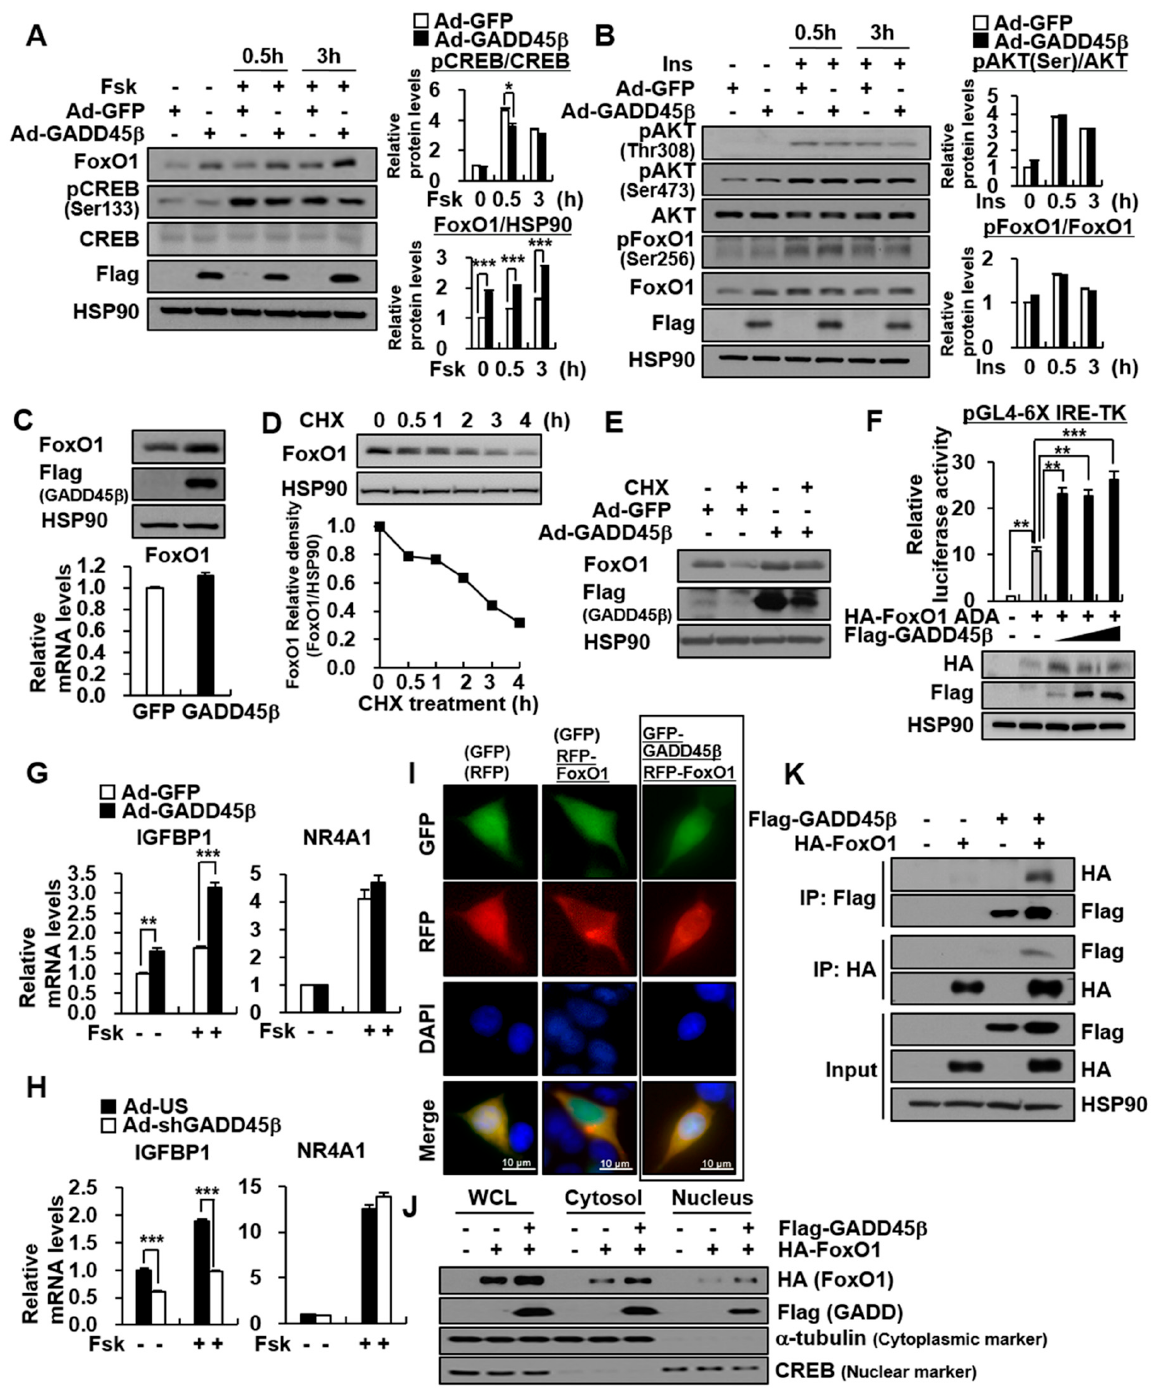
Figure 3. GADD45 β induces hepatic gluconeogenesis by enhancing FoxO1 protein stability rather than Akt-mediated FoxO1 phosphorylation and Fsk-induced CREB phosphorylation. ( A – C ) Mouse primary hepatocytes were infected with Ad-GFP or Ad-GADD45 β for 48 h. ( A ) Cells were treated with 10 uM Fsk for 0.5 or 3 h. Western blot showing the effects of GADD45 β on FoxO1 protein level and CREB phosphorylation level ( left ). Bar graph showing the ratio of pCREB to CREB and FoxO1 toHSP90 ( right ). ( B ) Cell were treated with 100 nM insulin for 0.5 or 3 h. Western blot showing the effects of GADD45 β on AKT phosphorylation level and FoxO1 phosphorylation level ( left ). Bar graph showing the ratio of pAKT (Ser473) to AKT and pFoxO1 to FoxO1 quantified by ImageJ ( right ). ( C ) Western blot ( upper ) and qPCR analysis ( bottom ) showing the effects of GADD45 β on FoxO1 protein and mRNA level. ( D ) Cycloheximide (CHX) chase assay showing the degradation rates of the existing FoxO1 protein. Mouse primary hepatocytes were treated with 25 ug/mL Cycloheximide (CHX) for 0.5, 1, 2, 3, or 4 h. Western blot ( upper ) and its quantification graph ( bottom ) showing FoxO1 protein levels. ( E ) Western blot and CHX chase assay showing the effects of GADD45 β on FoxO1 protein stability. Mouse primary hepato- cytes infected with Ad-GFP or Ad-GADD45 β were treated with or without 25 ug/mL CHX for 2 h. ( F ) Luciferase assay showing effects of GADD45 β on FoxO1-induced 6X-IRE promoter. HepG2 cells were co-transfected with pGL4-6X-IRE-